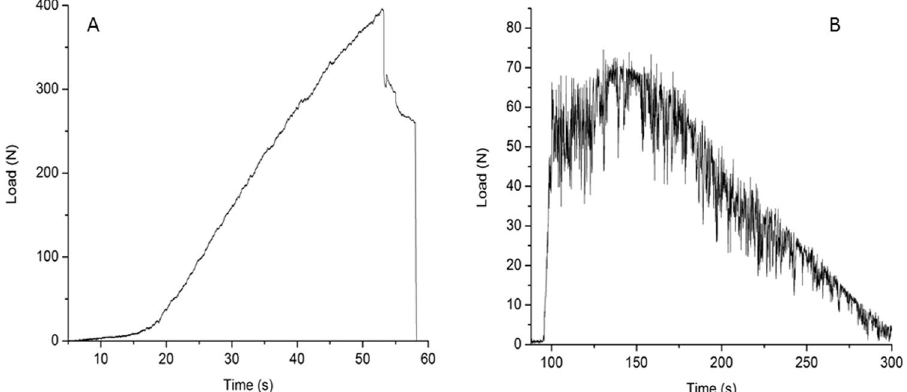
Figure 1. Typical load-time curves from the mechanical tests. ( A ) from a DC test; ( B ) from a PO test. Note that displacement = time × 0.5 mm/min.